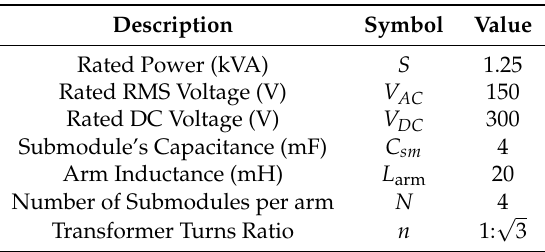
Figure 2. Overview of the MMC STATCOM control system. Table 1. Parameters of the MMC STATCOM